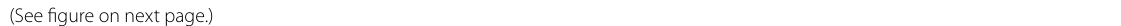
Fig. 9 Effect of ITGB3 siRNA transfection on the biological function of miR-351 -silenced cells. A The expression levels of ITGB3 and apoptosis-related proteins were detected by western blot. B – E The gray values of ITGB3 Bcl-2, Bax, and active Caspase-3 protein western blot bands were statistically quantified. F Oil red O was used to detect oil accumulation in cells. The scale bar represents 50 μm. G Flow cytometry was used to detect the apoptosis levels of miR-351 cell lines after transfection with ITGB3 siRNA. H The results were statistically quantified by flow cytometry. **P < 0.01, *P < 0.05, vs. the control group. # P < 0.05 represents the comparison between the two groups of connections. N